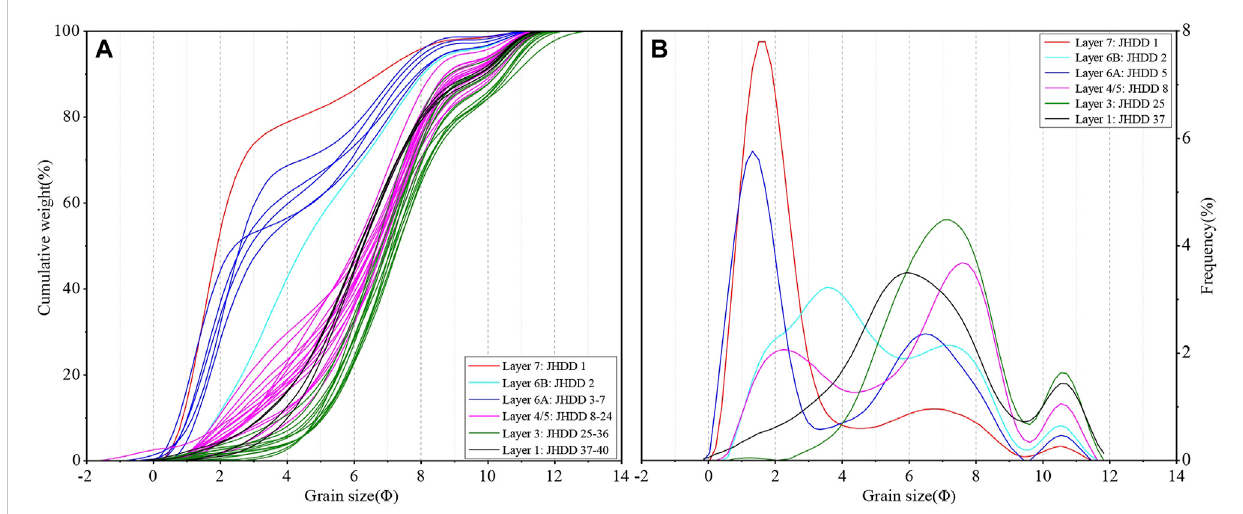
FIGURE 9 Grain size cumulative frequency chart (A) and frequency distribution curves (B) of the Dadong bulk